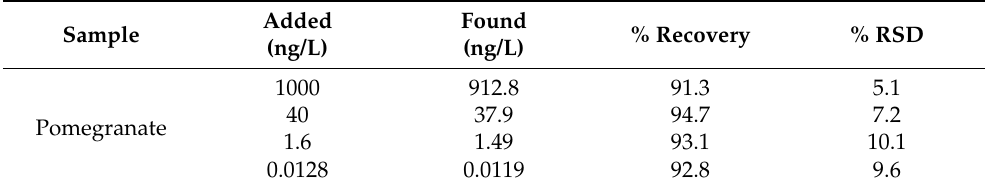
Table 2. Real sample analysis of anti-parathion/Au-IDE by spiking known amount of parathion concentration in pomegranate juice.